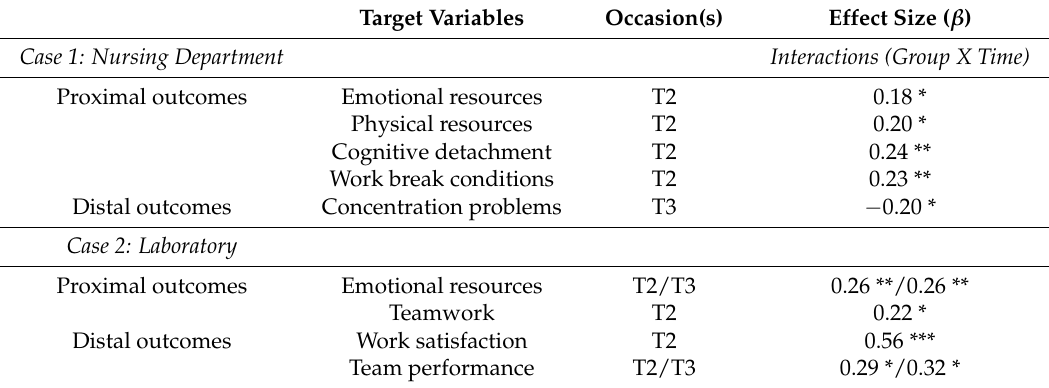
Table 4. Overview of the significant multilevel results for the target variables within the participating